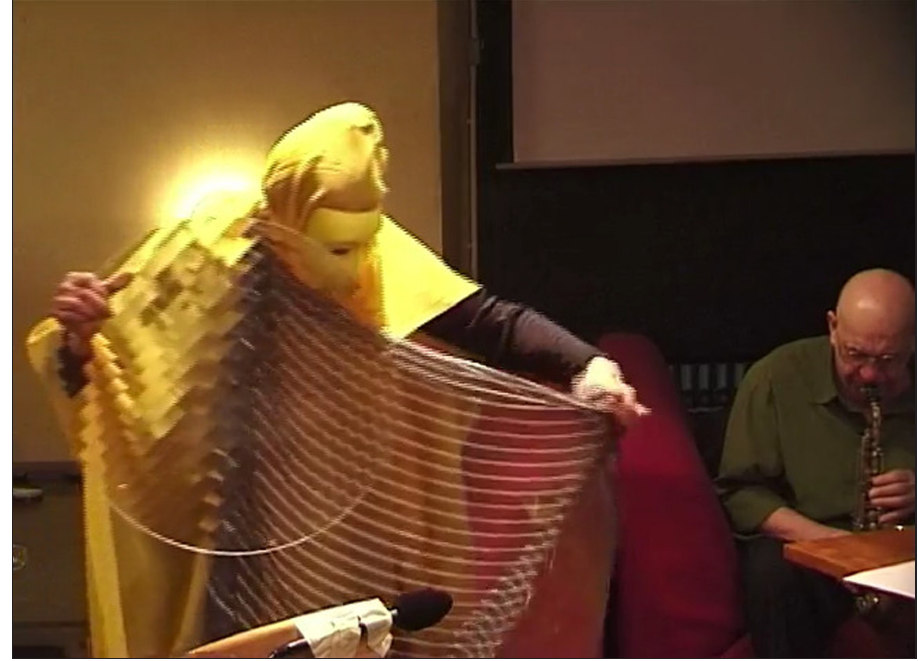
Figure 1.1: (24.23) Jennifer Pike and Lol Coxhill with Birdyak at the RCA, London 2002. Courtesy of William Cobbing, Maddie Coxhill and Ulrike